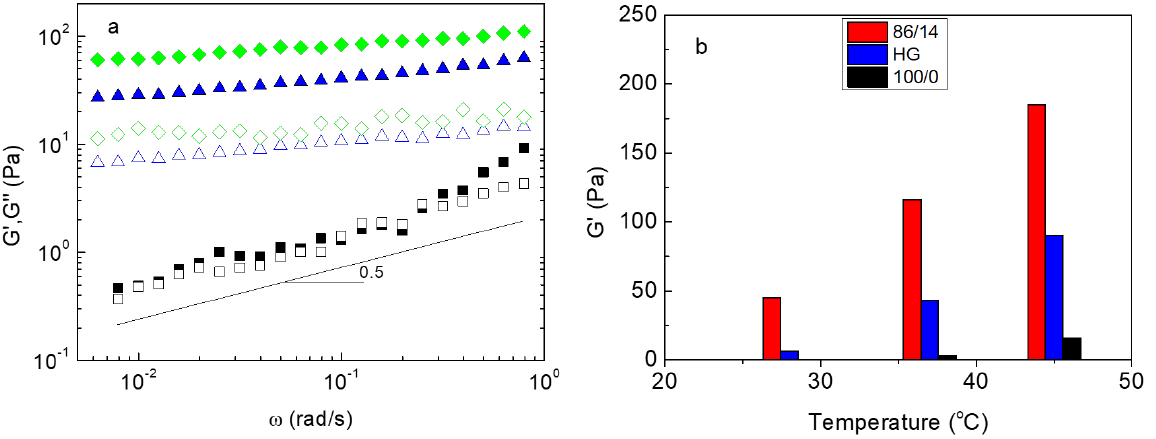
Figure 5. ( a ) G’ (closed symbols), G” (open symbols) as a function of the angular frequency of 5 wt% of ALG/HGC hydrogels at various temperatures: 28 °C (black, squares), 37 °C (blue, triangles) and 45 °C (green, rhombi) , the angle of the line is 0.5. ( b ) G’ at various temperatures for the hydrogels formed by ALG-g-P(NIPAM 86 - co -NtBAM 14 ) (red bars), ALG/HGC (blue bars), and ALG-g-P(NIPAM) (black bars). The data were obtained from frequency sweeps at 1 rad/s.